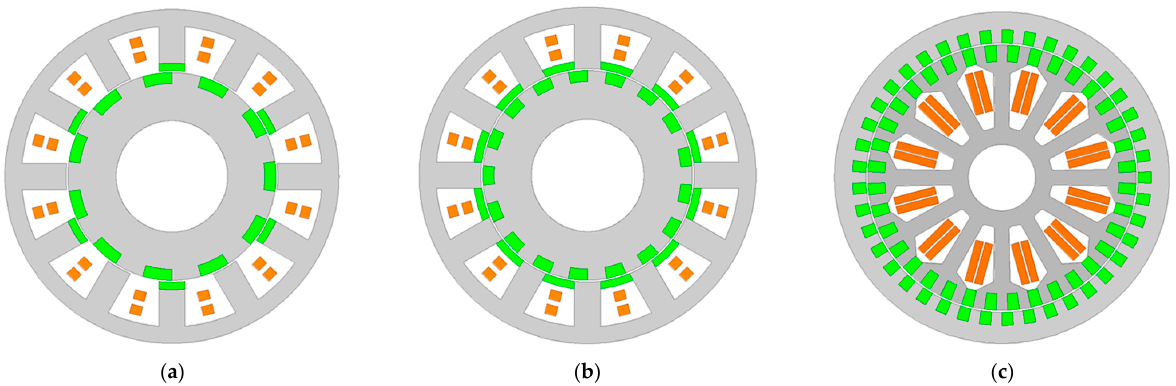
Figure 25. Configurations of dual-PM machines: ( a ) Stator-tooth PM type; ( b ) Stator-slot PM type; ( c ) Stator-multitooth PM type [54].